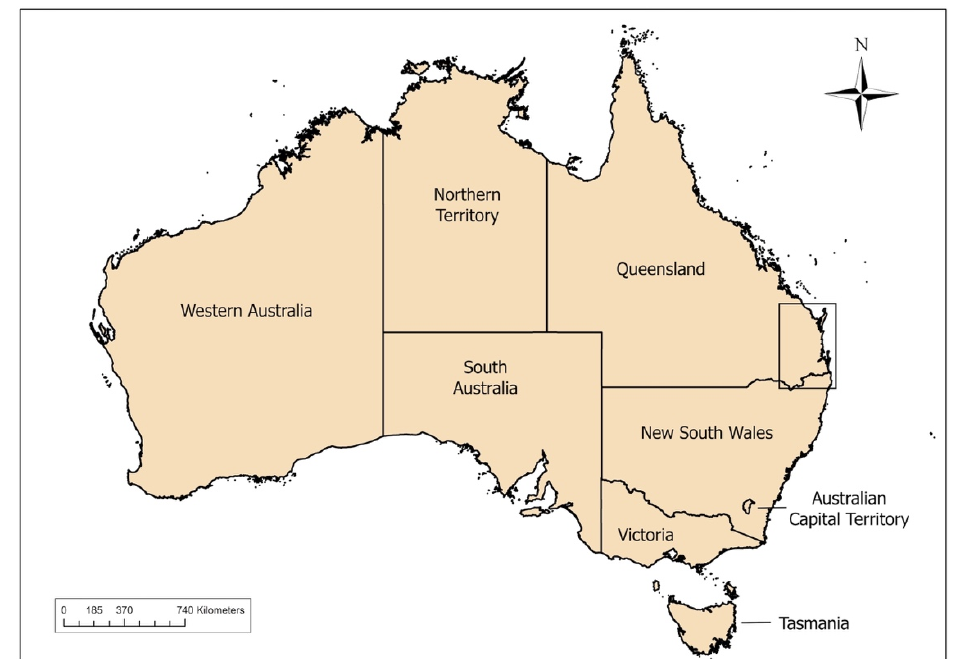
Figure 1. Region of wild-dog sampling (inset) between 2012 and 2015, in South East Queensland and Northeast New South Wales, Australia.